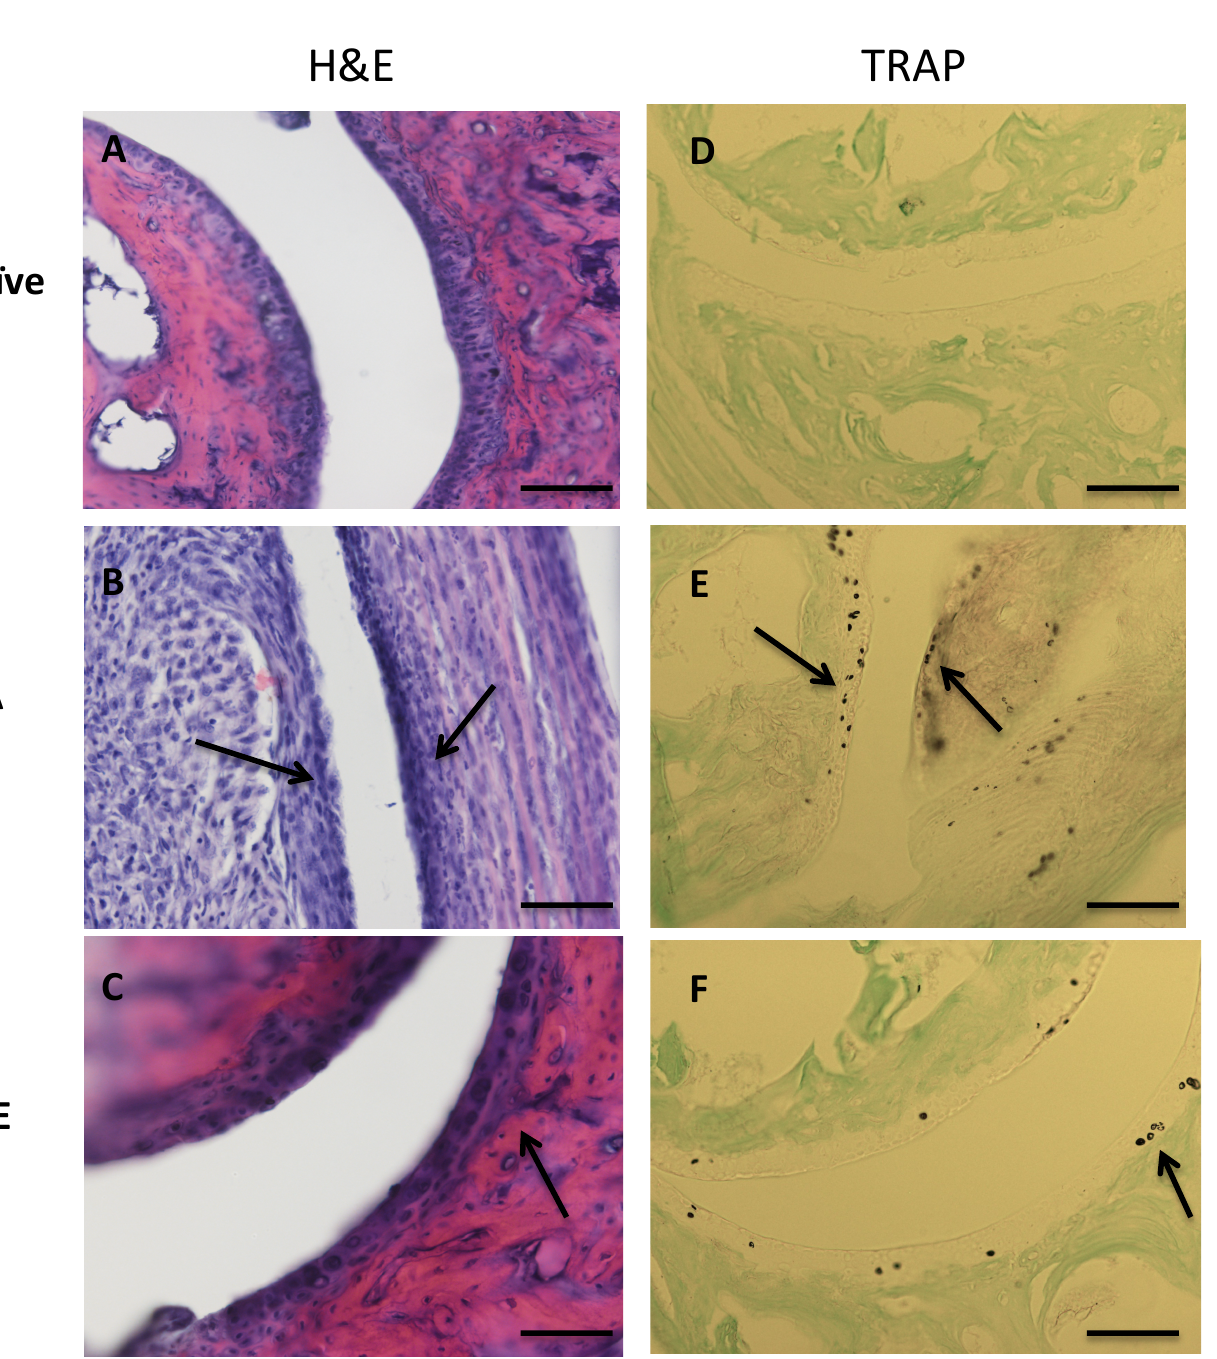
Figure 2. Histological representative images of frontal joint section at Day 43: effects of dietary OLE (0.025% w/w ) in synovial tissue, cartilage damage and bone erosion. Paw section from mice ( n = 10) was stained with H&E ( A – C ) to show inflammatory activity and TRAP ( D – F ) staining for bone erosion. ( A , D ) Naïve group, non-arthritic control animals fed with SD; ( B , E ) CIA, induced arthritic animals fed with SD; ( C , F ) OLE, induced arthritic animals fed with OLE enriched diet. Joint cartilage thinning due to arthritic damage (asterisk) and inflammatory infiltrates (arrow) were observed in SD-CIA mice ( B ), as well as increased osteoclast cells (arrow) ( E ). Original magnification × 100 ( A – C ) and × 200 ( D – F ). The pictures are representative of at least six independent experiments with similar